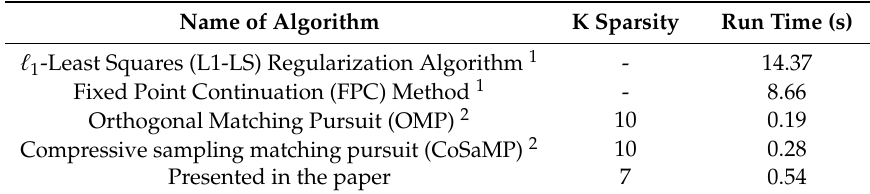
Table 4. Average running time of reconstruction algorithms [27,43].